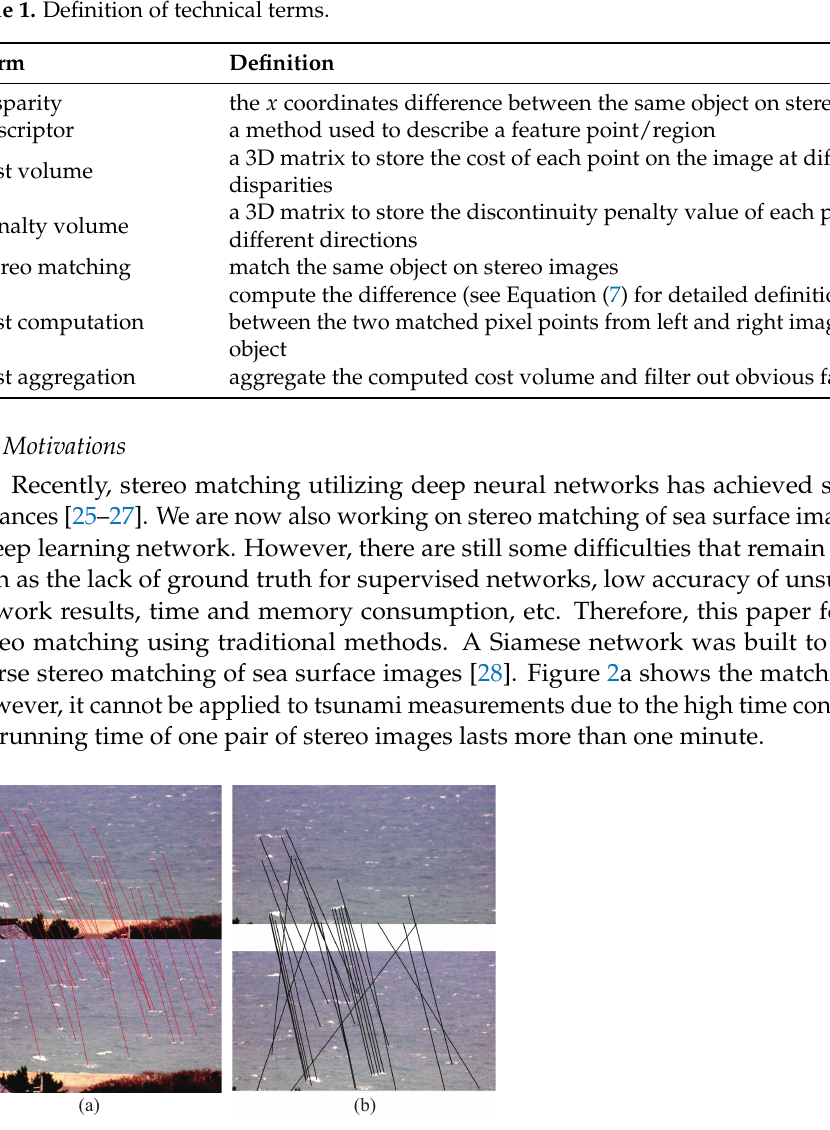
Figure 2. Examples of sparse matching: ( a ) result of Siamese network and ( b ) result of